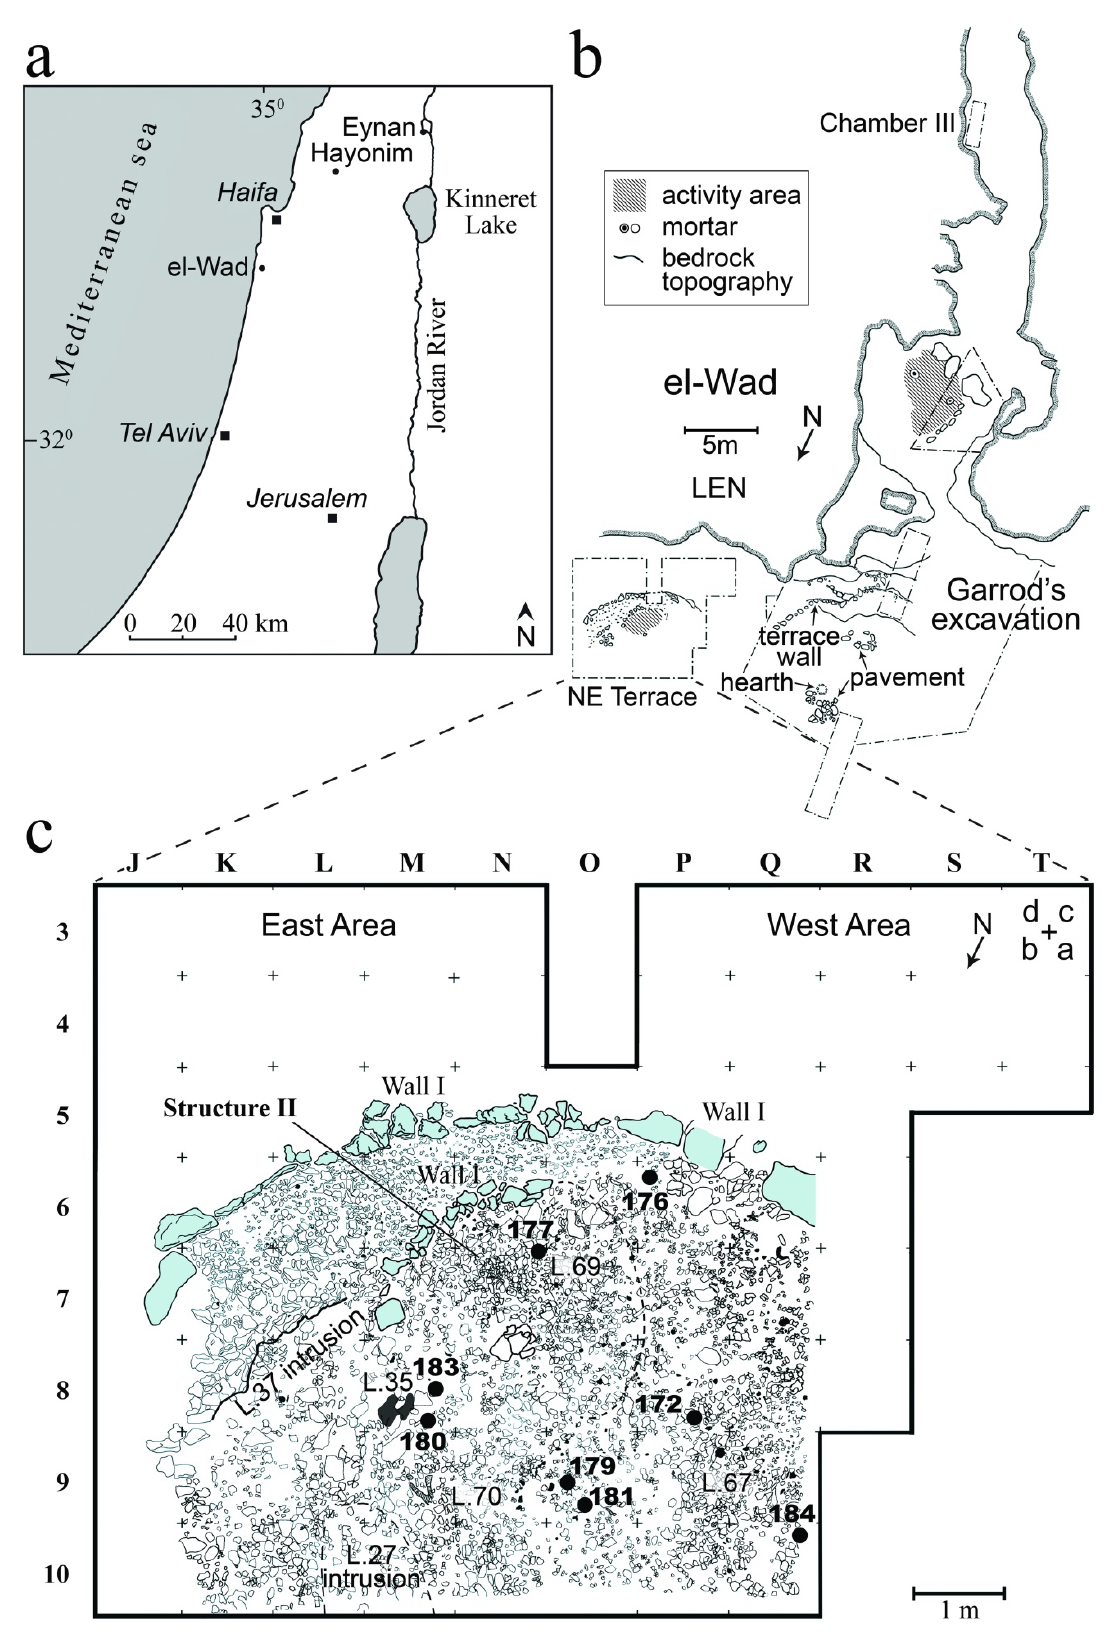
Figure 1. a) Map showing the location of the site of el-Wad, b) plan of el-Wad showing the cave and terrace, c) detailed plan of el-Wad terrace showing architectural features and location of the grooved basalts studied for use-wear